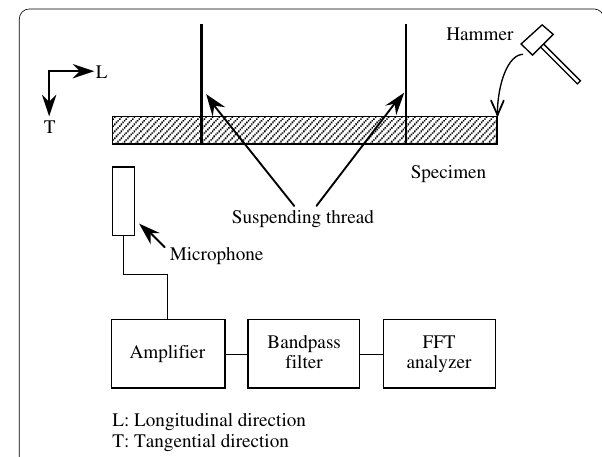
Fig. 2 Schematic diagram of the experimental setup for the free–free bending vibration